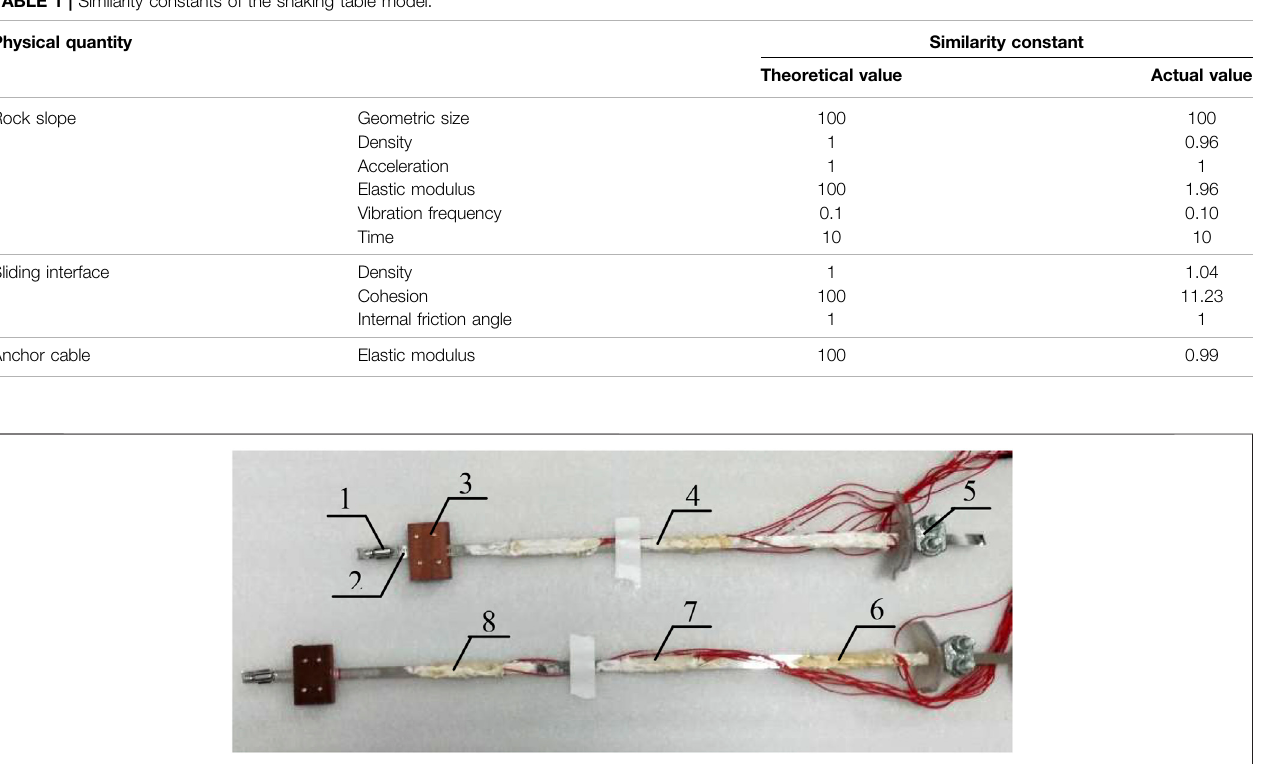
TABLE 1 | Similarity constants of the shaking table model.